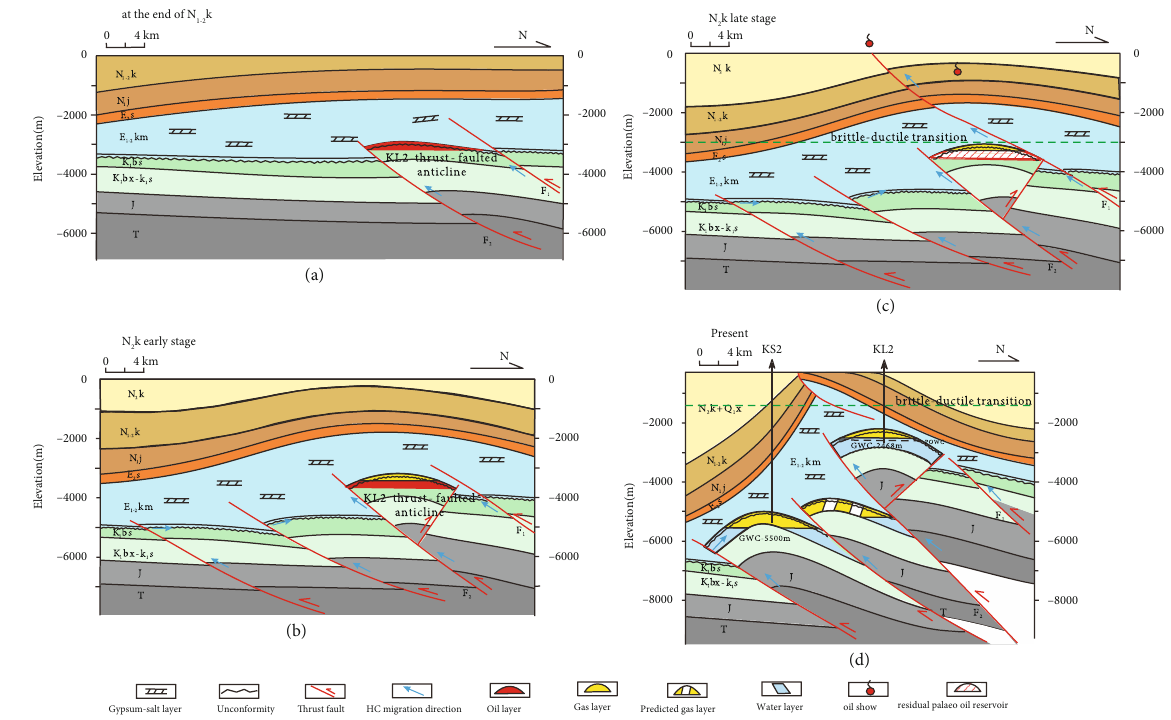
Figure 10: Proposed model of dynamic hydrocarbon accumulation in the Kela-2 gas fi